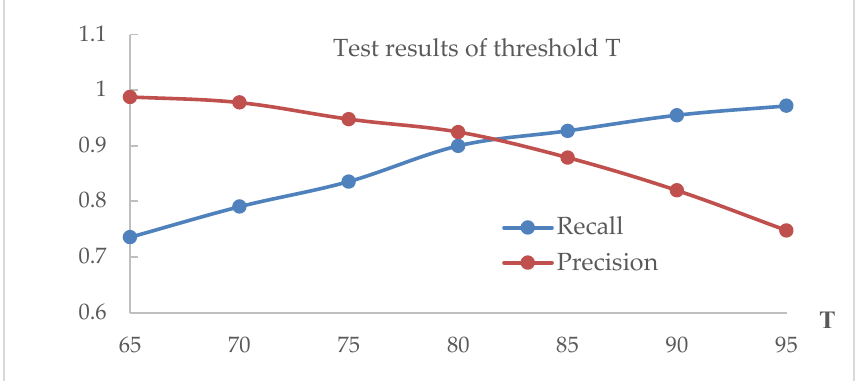
Figure 9. The test results of the threshold.